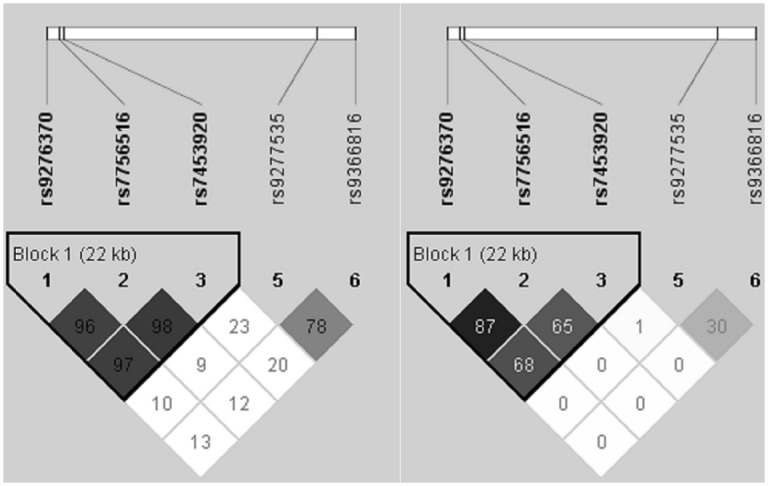
LD patterns of the 5 SNPs.LD patterns based on the D’ (left side) and r2 (right side) measures of the five associated SNPs for 625 individuals in the GWAS scan. The LD block built up by the rs9276370, rs7756516 and rs7453920 suggest that they were significantly associated with each other. The rs9366816 and rs9277535 SNPs were independent from each other and from the other three SNPs.